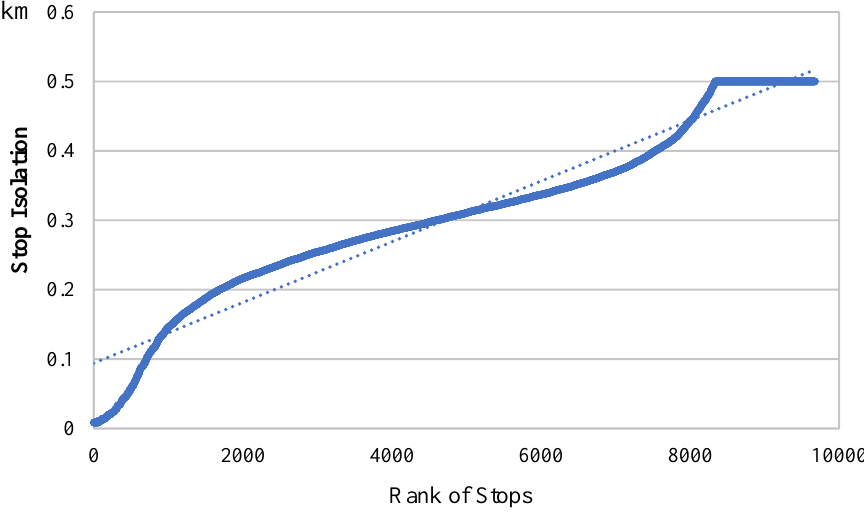
Figure 6. Sorted 500 m-Stop Isolation of stops (solid line) and the increase curve (dotted line).